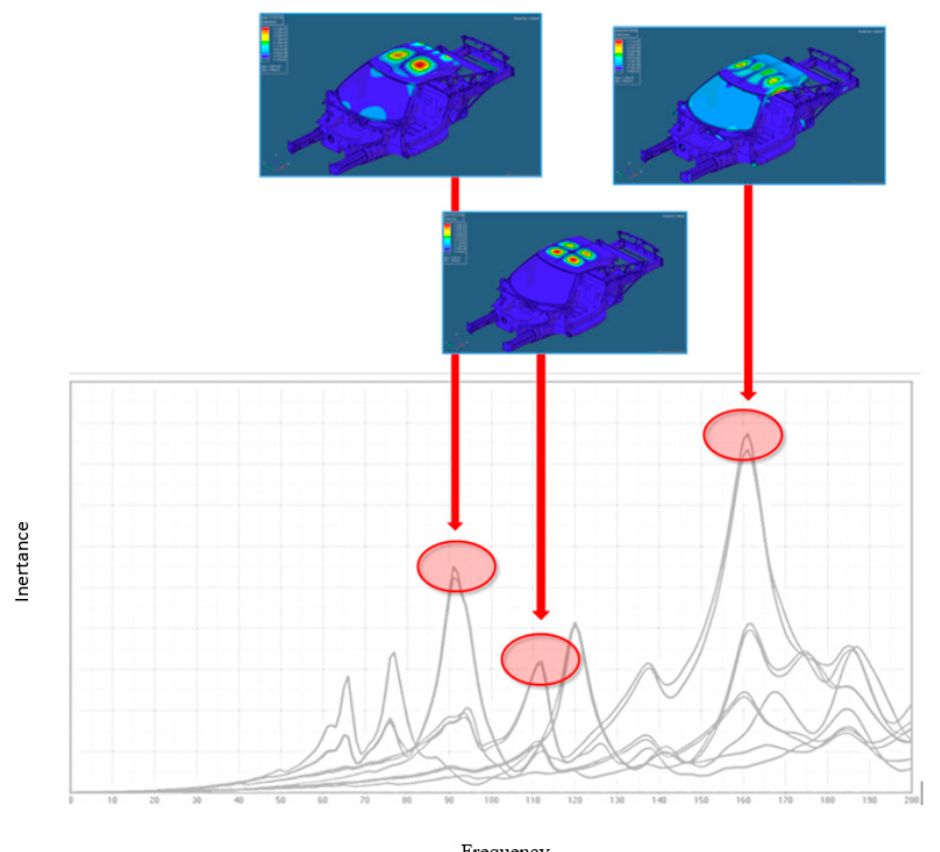
Figure 19. Identification of 4C car pavilion modes: Inertances vs. frequency.